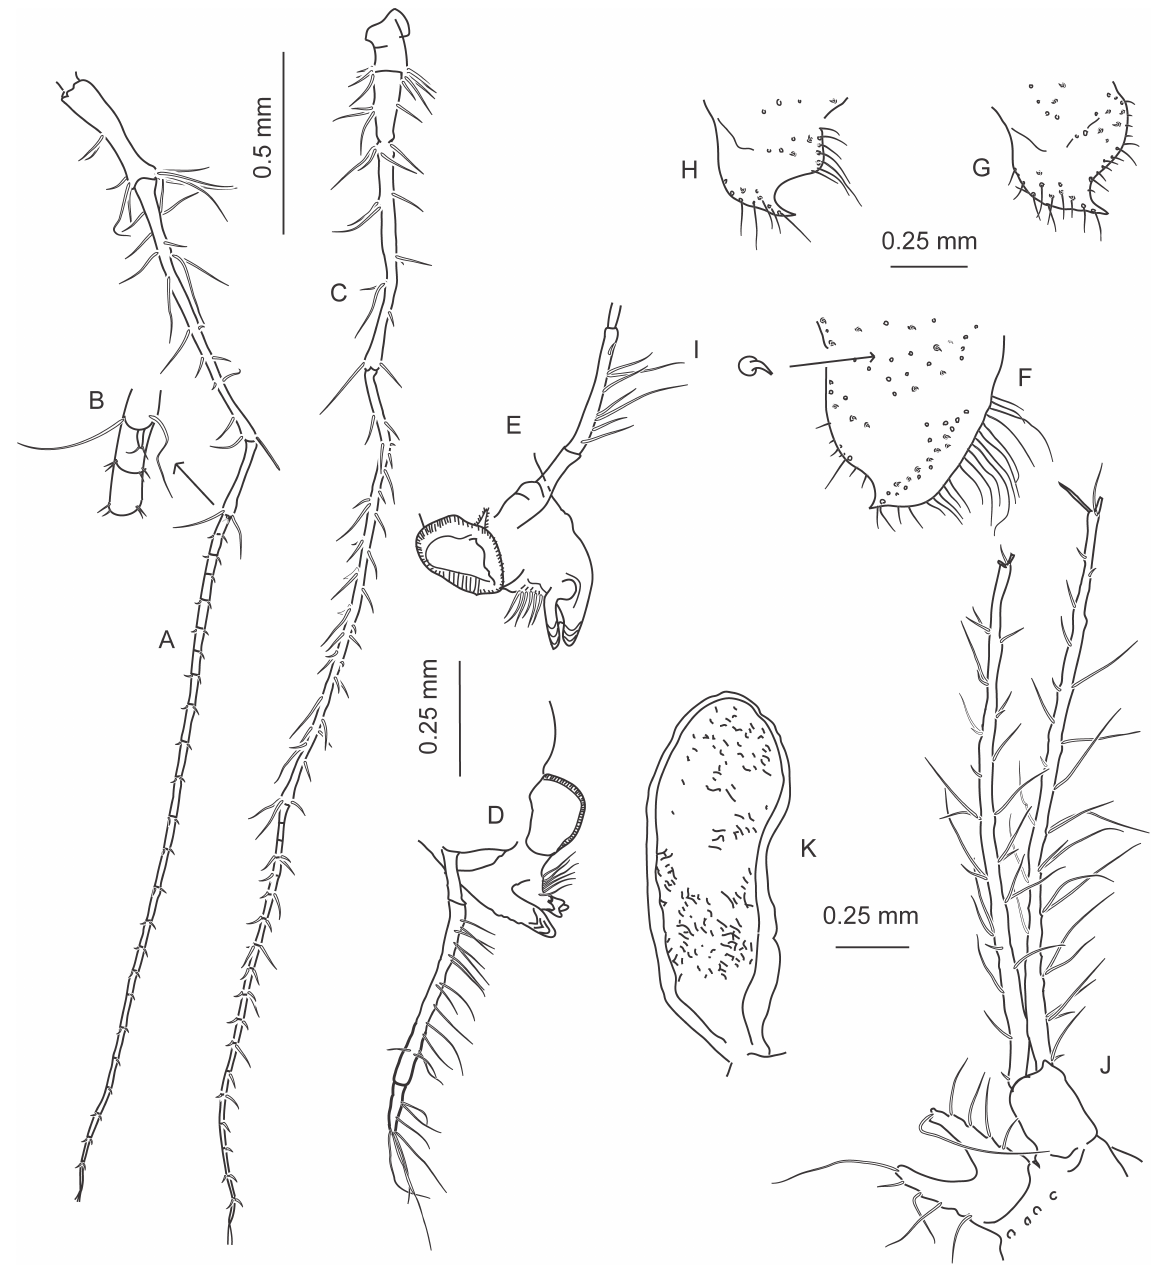
Fig. 9. Lepechinella norvegica sp. nov., allotype, ♀. A . A1. B . Accessory flagellum of A1. C . Female A2. D–E . Right and left mandible. F . Right Ep1. G . Left Ep2. H . Left Ep3. I . Spine on Ep 1. J . Telson and left U3. K . Gill